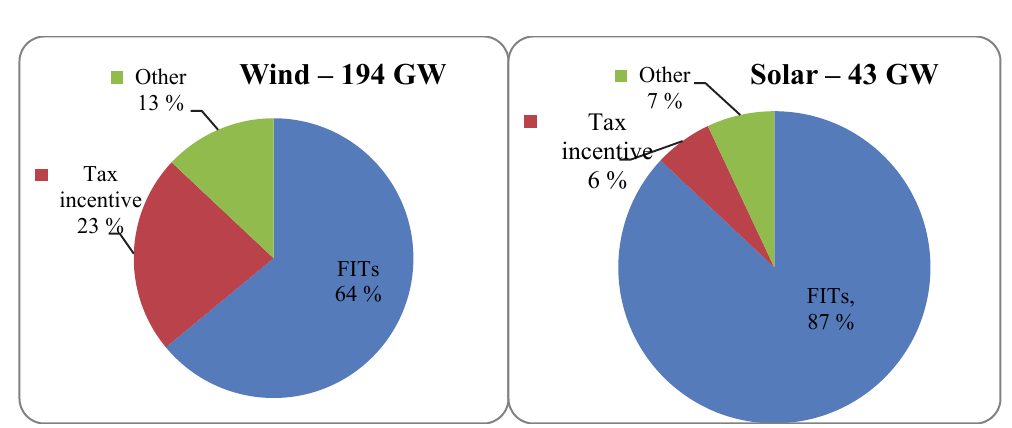
Fig. 1. Global installed capacity by incentive type (Tringas, 2011).